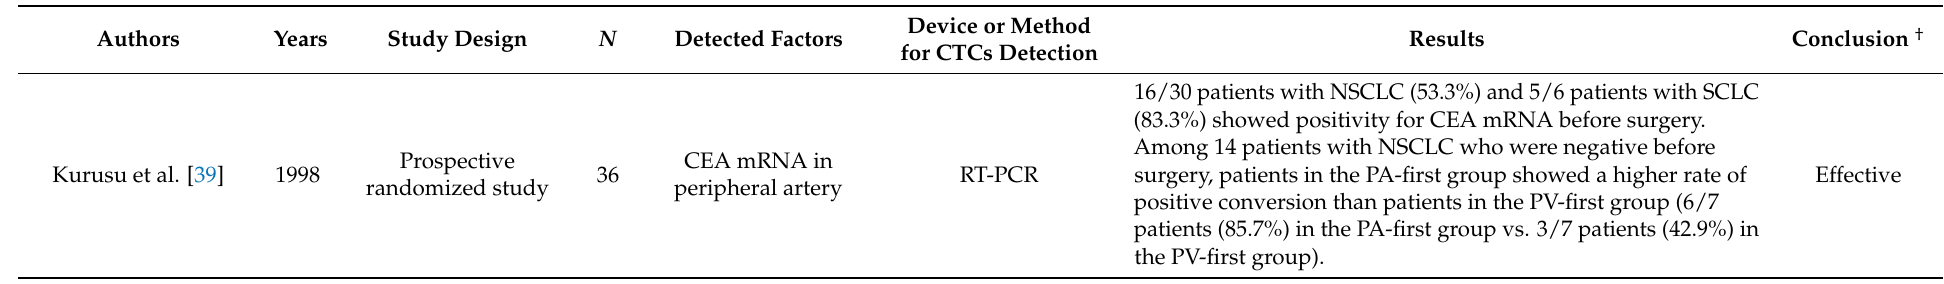
Table 2. Summary of studies investigating the relationship between the PV-first technique and change in postoperative CTCs detection in non-small-cell lung